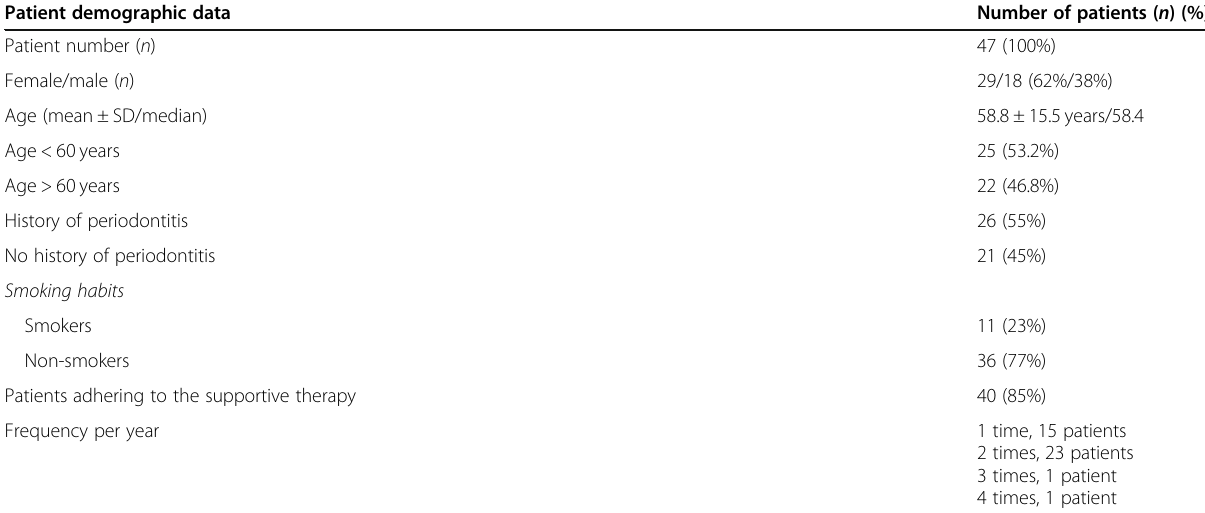
Table 1 Patient demographic data Patient demographic data